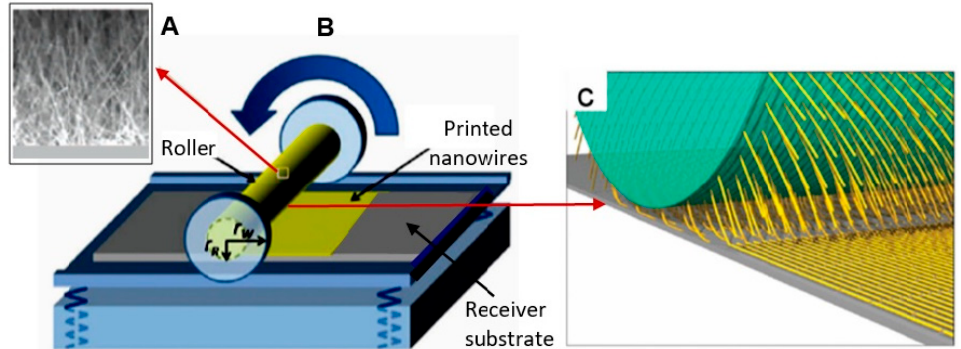
Figure 17. Schematic diagram illustrating the roll printing technique for NWs alignment: ( A ) SEM image of NWs grown perpendicularly to the surface of the cylindrical substrate; ( B ) installation for NWs alignment; ( C ) the mechanism of a nanowire transfer. The NWs are oriented and transferred to the receiving substrate by applying a directional shear force, resulting in the printing of sub-monolayer parallel NW arrays on the receiving substrate. Reproduced with permission from Hu et al. [269]. Copyright 2020: Royal Society of Chemistry.